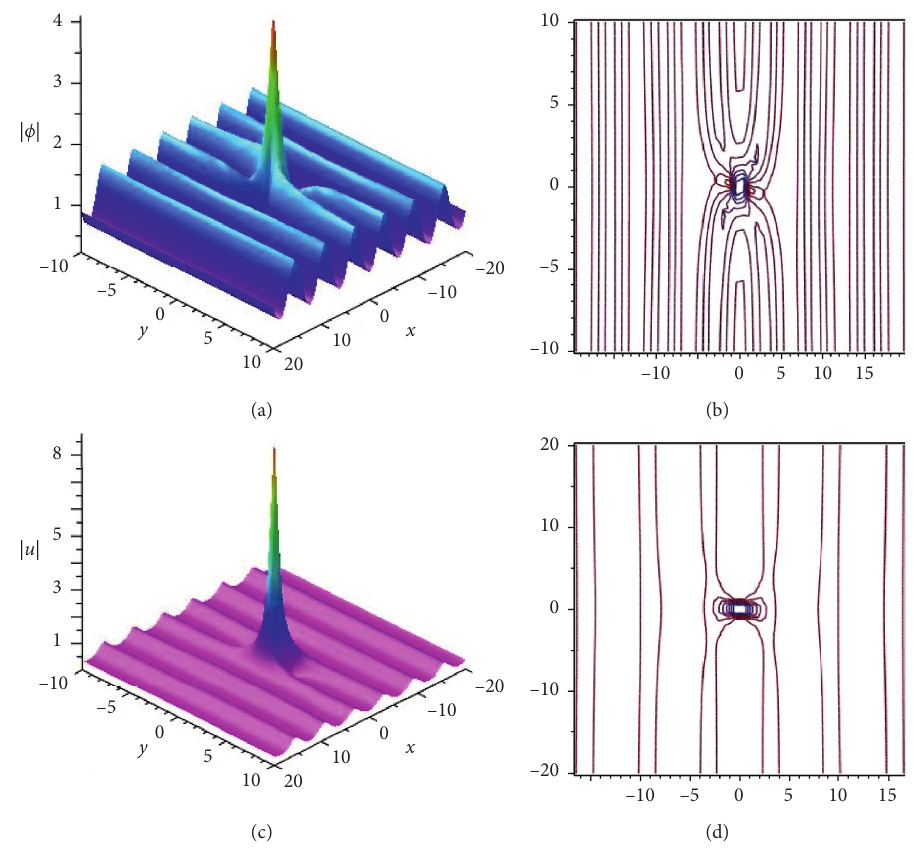
Figure 7: Semirational solutions constituting of a lump and periodic line waves for the local Mel ′ nikov equation with parameters � 1 ,P � 1 , and η 0 � − ( π /6 ) . The panels (b) and (d) are the contour plots of the panels (a) and (c), λ 0 3 3